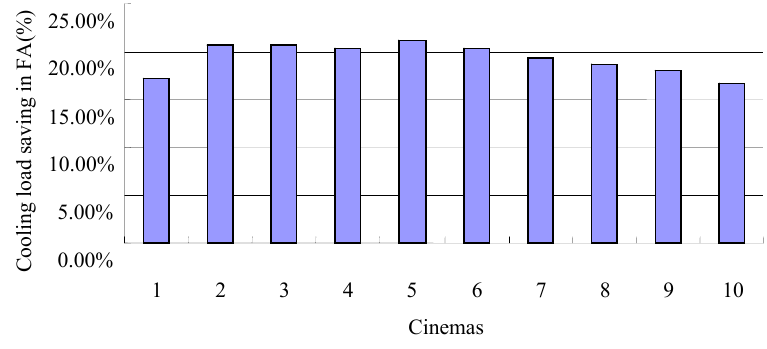
Figure 3. Cooling load saving percentage in fresh air system.